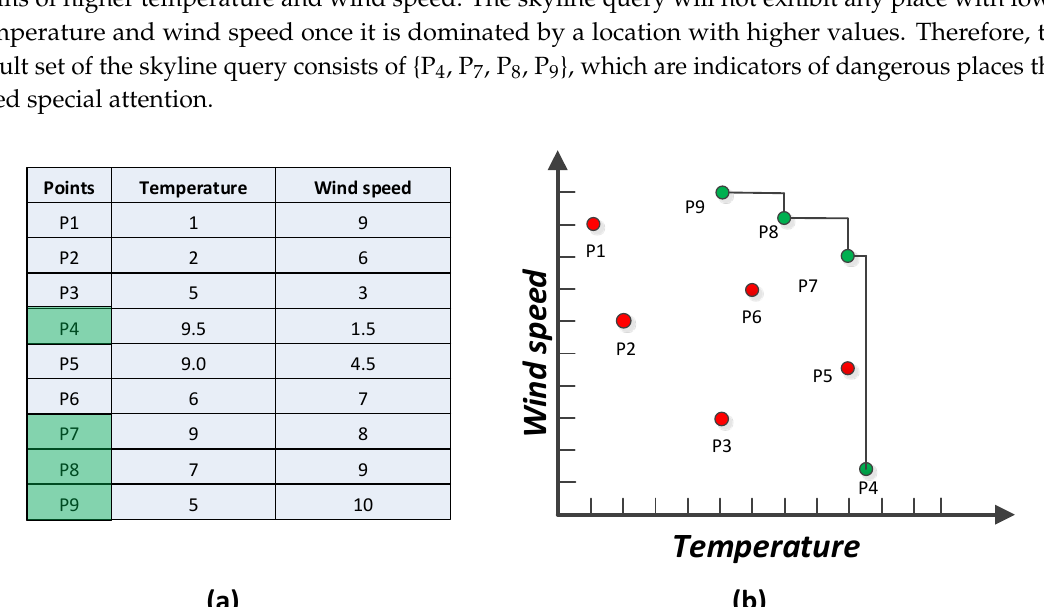
Figure 1. ( a ) TS and ( b ) DS (q, X).